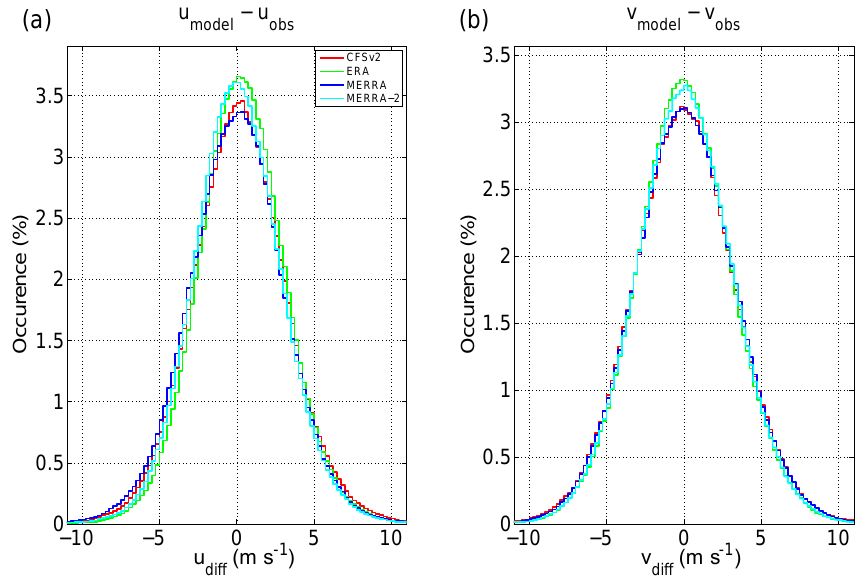
Figure 3. Zonal and meridional wind difference histogram outlines. Histograms are binned by steps of 0.25ms − 1 . Corresponding statistics are shown in Table 2.